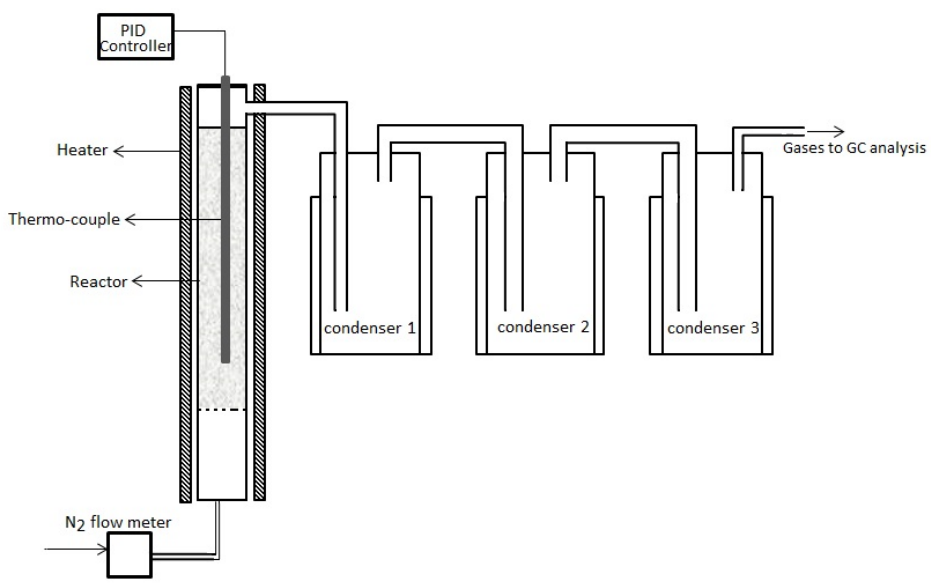
Figure 1. Process pathway for production of hydrocarbon fuels from domestic plastic waste and virgin virgin plastics.